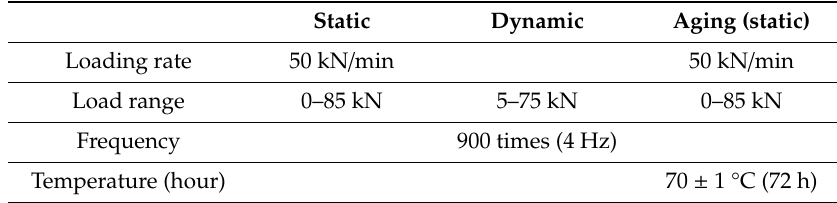
Figure 16. Rail pad samples. ( a ) New rail pad and ( b ) used rail pad (corroded rail pad). Table 4. Spring sti ff ness test conditions of rail